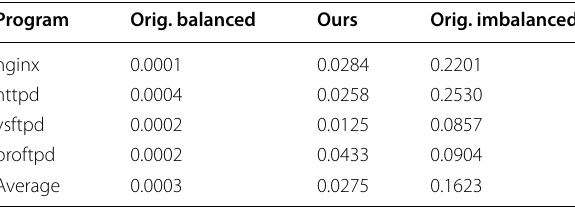
Table 6 False positive rate comparison with model trained using balanced data